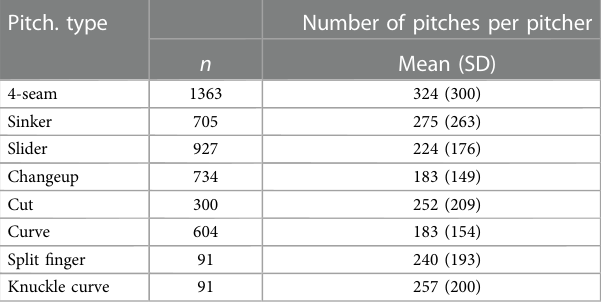
TABLE 1 Number of data for each type of